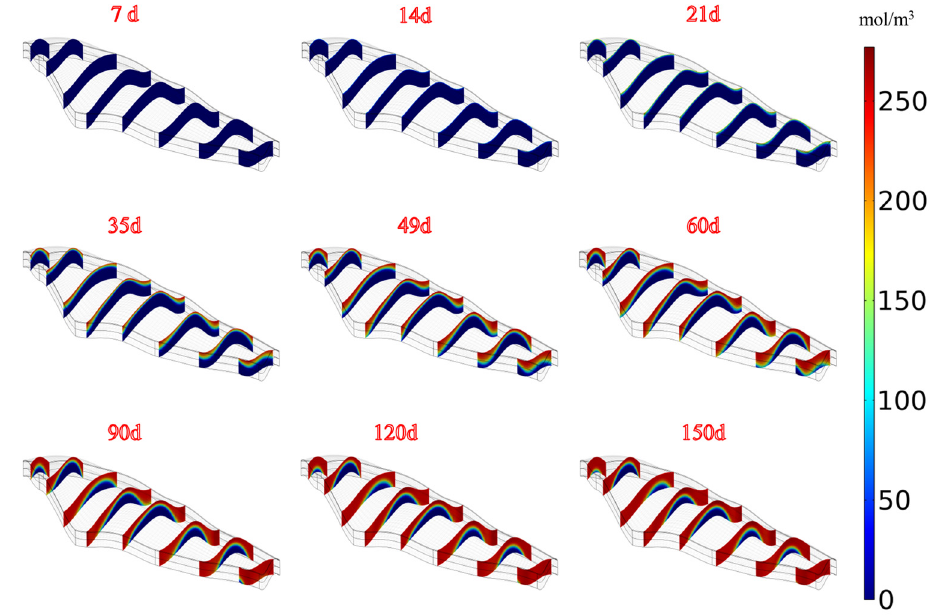
Figure 16. Cloud image of the Mg 2+ migration profile in the stope.